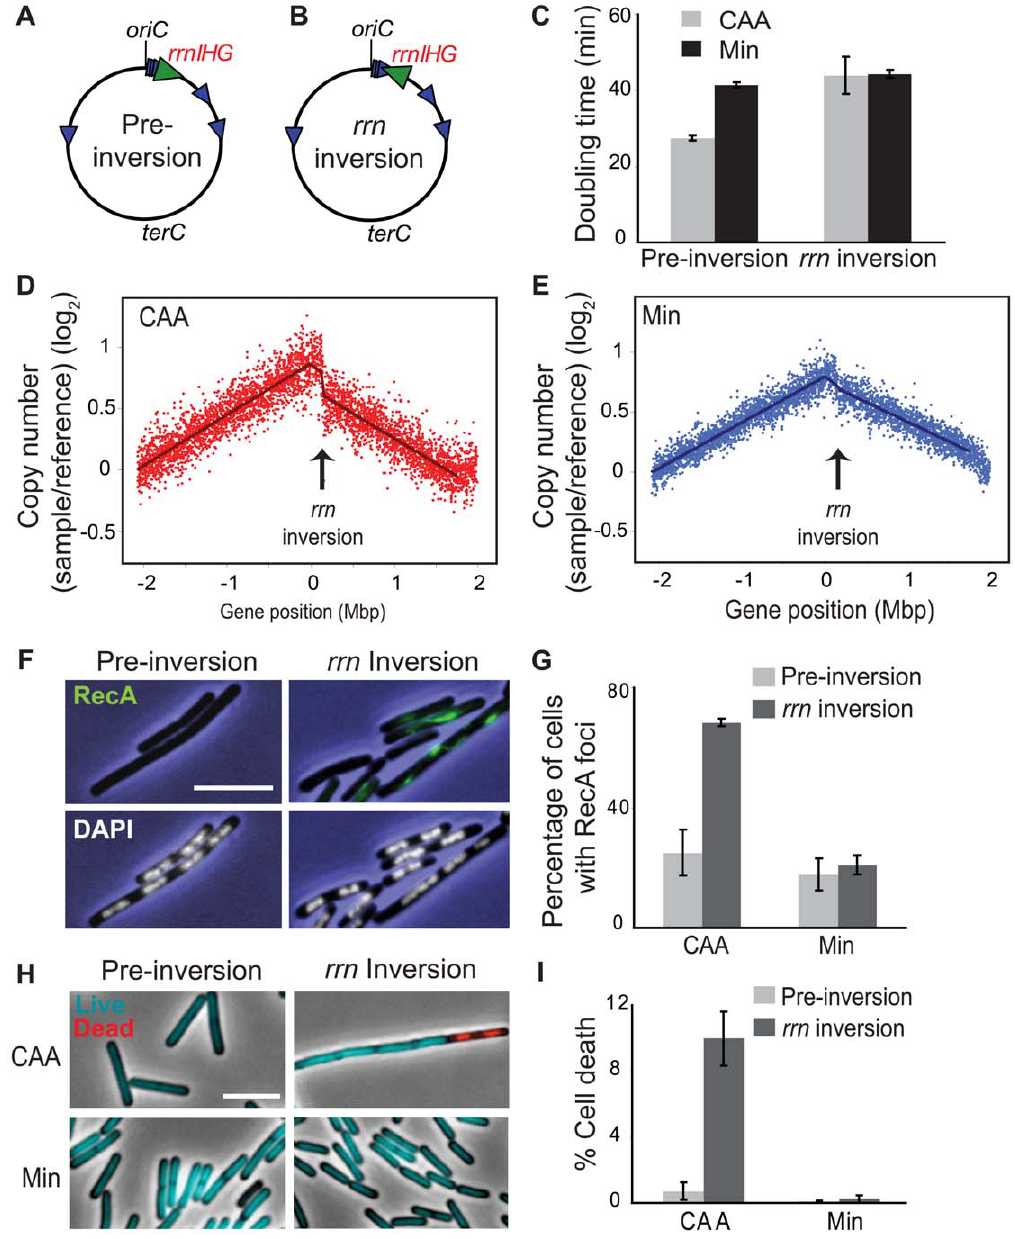
Figure 5. Inversion of rrnIHG impedes replication, triggers RecA recruitment, and elevates cell death. (A,B) Schematic diagrams of the chromosomes (black circles) of the pre-inversion control strain (A) and the rrnIHG ( rrn ) inversion strain (B). Blue arrowheads: rRNA operons; large green arrowhead: rrnIHG cluster. (C) Doubling times of the pre-inversion and rrn inversion strains at 37 u C in CAA (grey bars) and Min (black bars). (D,E) Asynchronous gene dosage profiles of the rrn inversion strain in CAA (D) and Min (E). Profiles were obtained from asynchronous cultures grown at 37 u C in the indicated media to OD 600 , 0.5. Average ratios of copy number (log 2 ) in the rrn inversion strain relative to fully-replicated control are plotted against the genomic position. Arrows indicate the position of the rrnIHG inversion. (F) RecA recruitment and nucleoid morphology in the pre- inversion and rrn inversion strains in CAA, obtained as described in Figure 3A. Blue: phase contrast images; green: RecA foci; white: nucleoids stained with DAPI. (G) Average percentage of cells with RecA recruitment in the indicated media. Light grey bars: pre-inversion control; dark grey bars: rrn inversion. (H) Live/dead staining of the pre-inversion and rrn inversion strains grown in CAA and Min. Images were obtained as described in Figure 3D. Cyan: live cells; red: dead cells. (I) Average percentages of dead cells in the pre-inversion (light grey bars) and rrn inversion (dark grey bars) strains. The cell length that was stained with propidium iodide was divided by the total length of cells in each field. Scale bar in F and H: 5 m m.